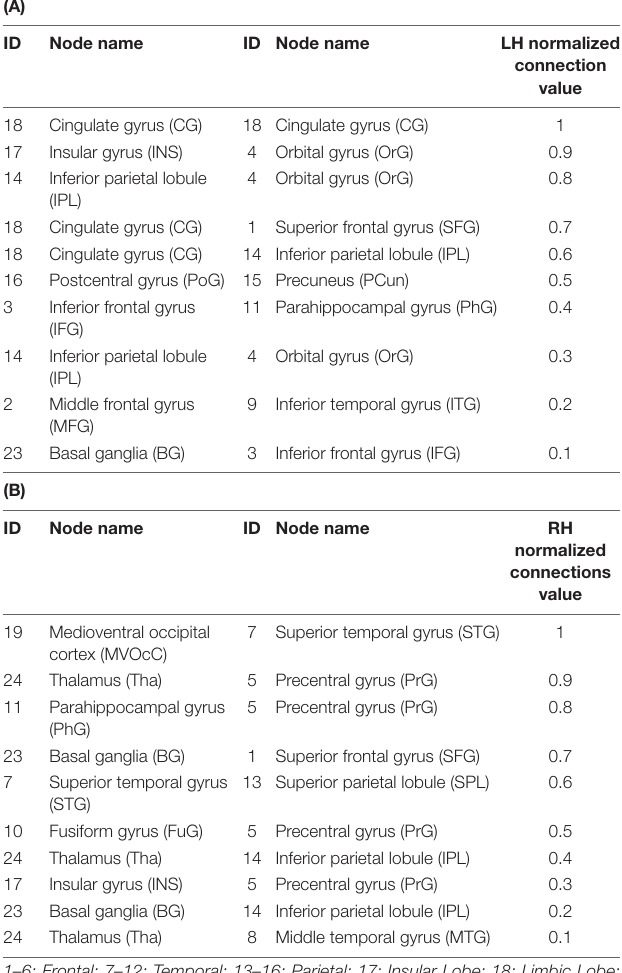
TABLE 1 | The top 10 connections in LH (A) and RH (B) with higher importance in the prediction of the improvement rate in the UPDRS-III score after DBS surgery in the medication-off